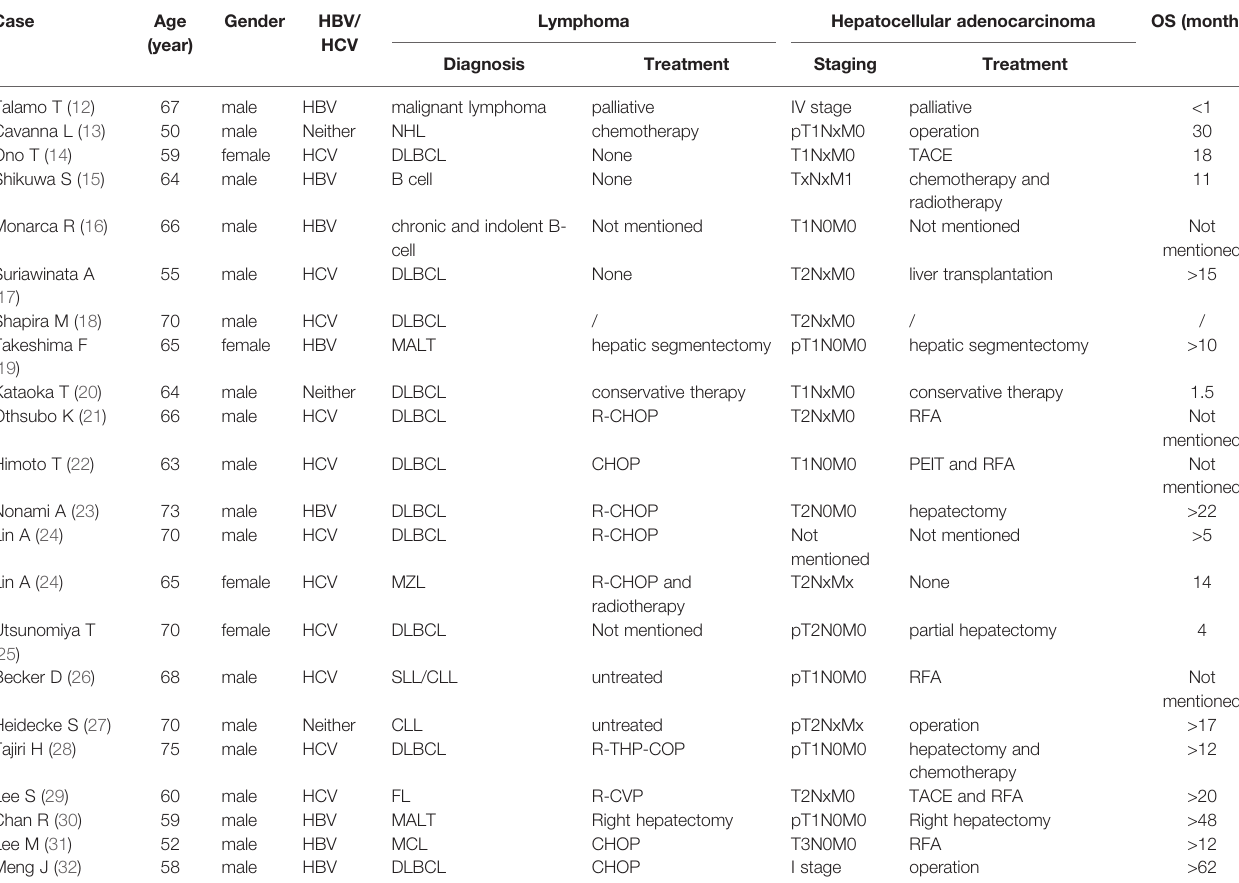
TABLE 2 | Clinical information of hepatocellular carcinoma with lymphoma